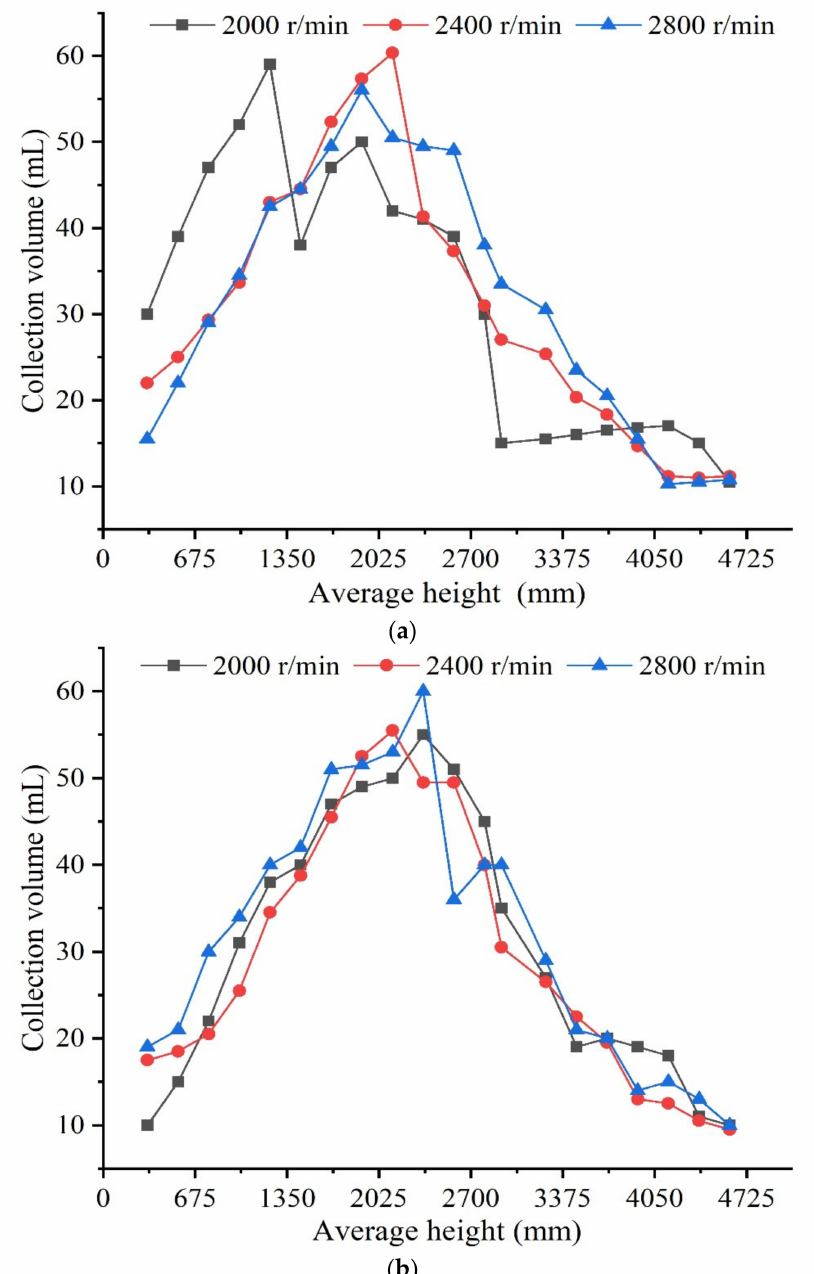
Figure 5. Influence of the blower speed on the collection volume at different spray angles (L = 1.0 m). ( a ) Influence of the blower speed on the collection volume (W = 60 ◦ ). ( b ) Influence of the blower speed on the collection volume (W = 75 ◦